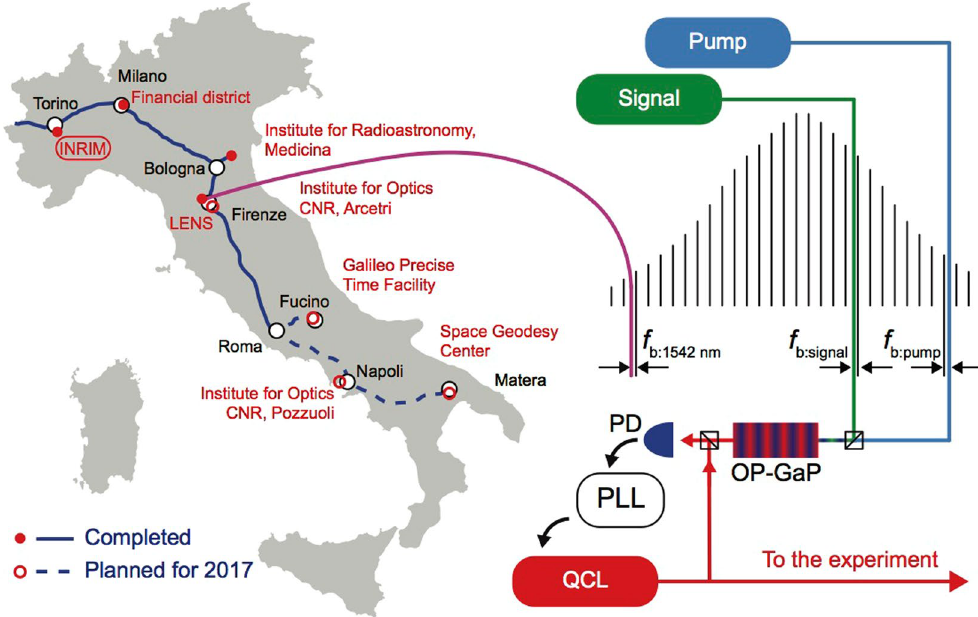
Figure 1. The left part of the figure shows the Italian fibre link network, blue line, with network nodes in red. At LENS/University of Florence (LENS in the following for brevity), the ultra stable laser at 1542 nm locks the repetition rate of a frequency comb. We measure the beat notes of two near-IR lasers against the frequency comb and keep their frequency difference constant with an indirect locking scheme to cancel out the comb noise contribution 29 . The two lasers are combined in an OP-GaP crystal to generate mid-IR light, to which we lock a quantum cascade laser. (The map is obtained on the basis of ©OpenStreetMap contributors (www. openstreetmap.org) licensed under the Creative Commons Attribution-ShareAlike 2.0 license (CC BY-SA) https://creativecommons.org/licenses/by-sa/2.0/. The basis was then modified to fit our figure and we took no care to maintain proportions or accuracy).